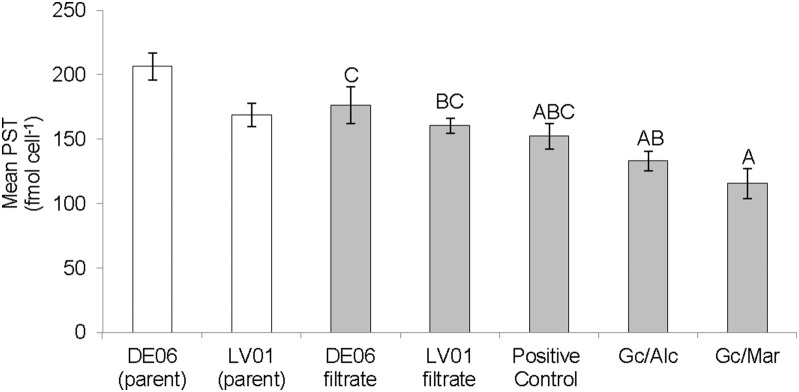
Toxin content (fmol cell−1) between Day 0 and Day 25 of G. catenatum cultures grown with different bacterial communities.Day 0 and Day 25 toxin content data for the offspring cultures were pooled as there was no significant difference. Toxicity of parent cultures (Day 25) included for comparison only. Superscripts indicate significant differences (p<0.05), means labelled with the same letter are not significantly different. Error bars ± SE, n = 5.